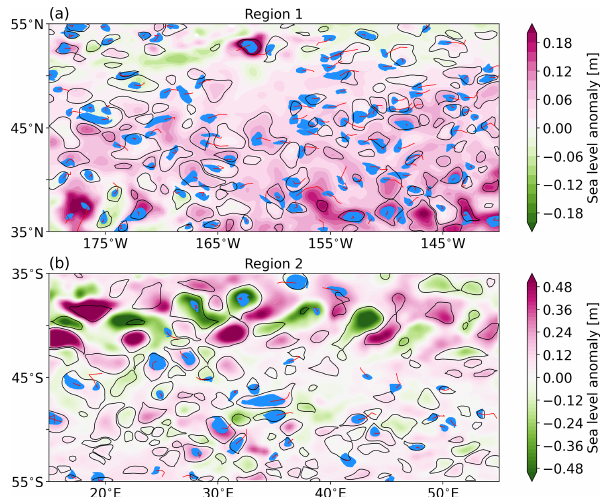
Figure 7. Locations of 30d RCLVs (blue dots) and SSH eddies ( > 30d, black contours) in (a) region 1 (blue box in Fig. 6a) and (b) region 2 (red box in Fig. 6a) on 1 January 2009. The red lines are the center trajectories of the RCLVs, and the color map represents the SLA